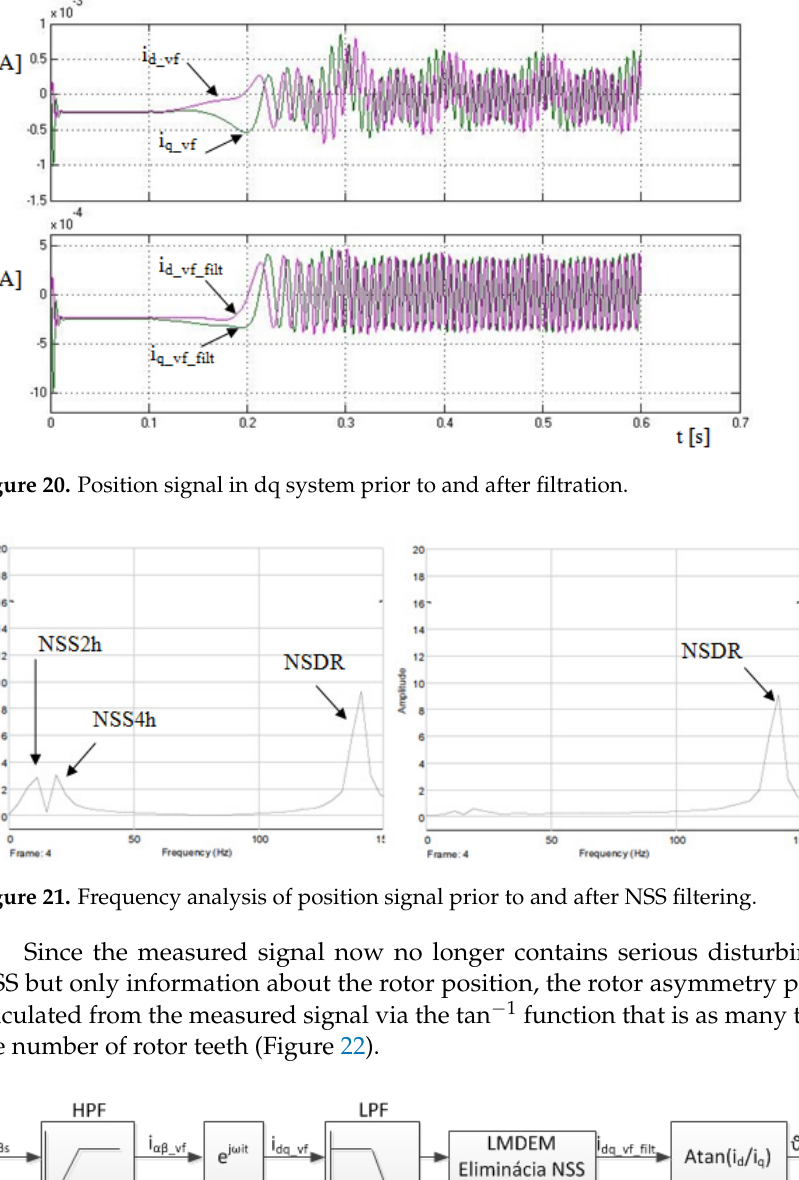
Figure 22. Block diagram of NSDR position estimation .